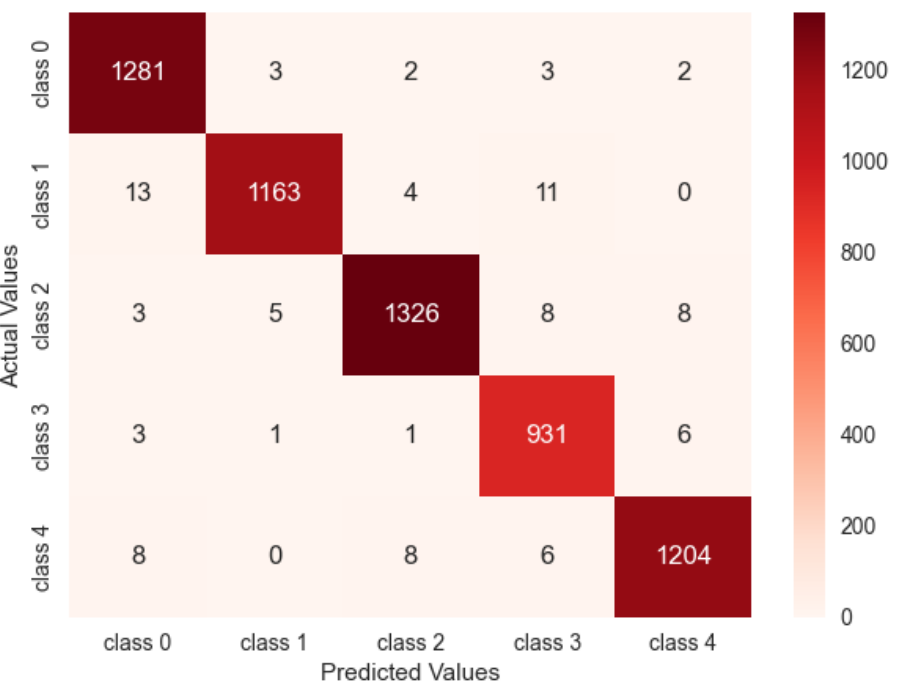
Figure 6. Confusion matrix for the SVM model.